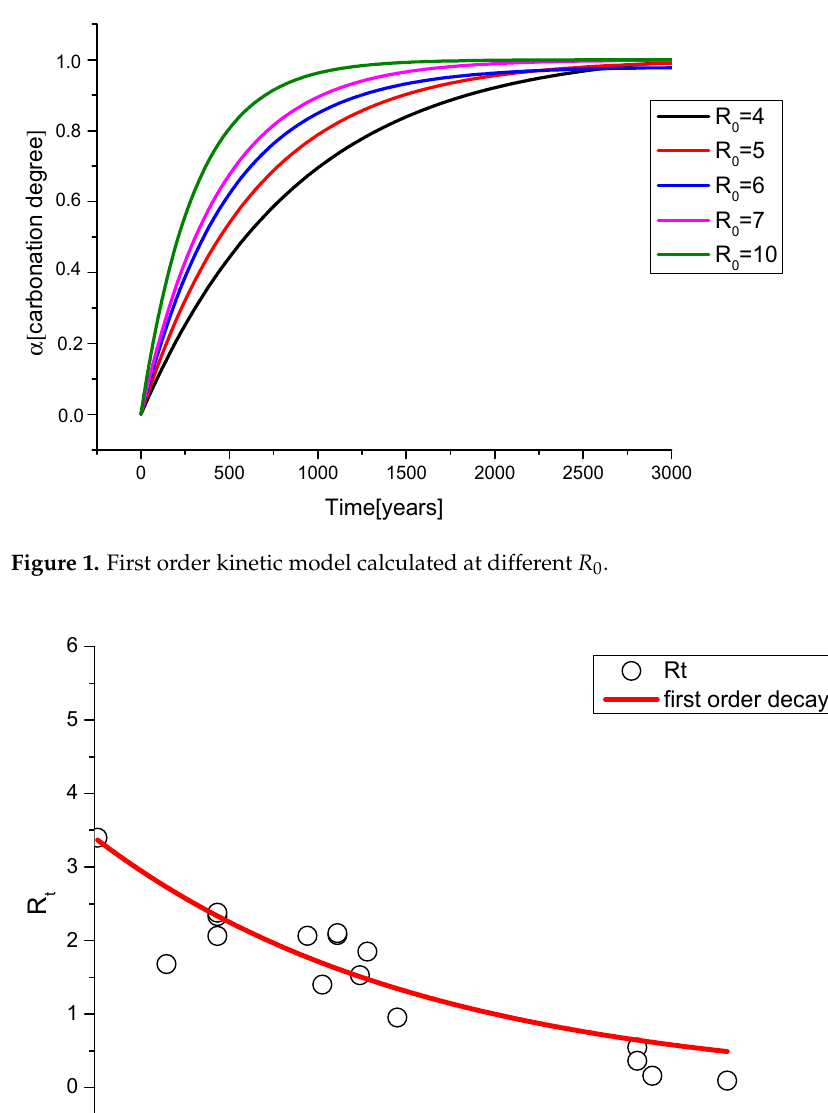
Figure 1. First order kinetic model calculated at different R 0 .